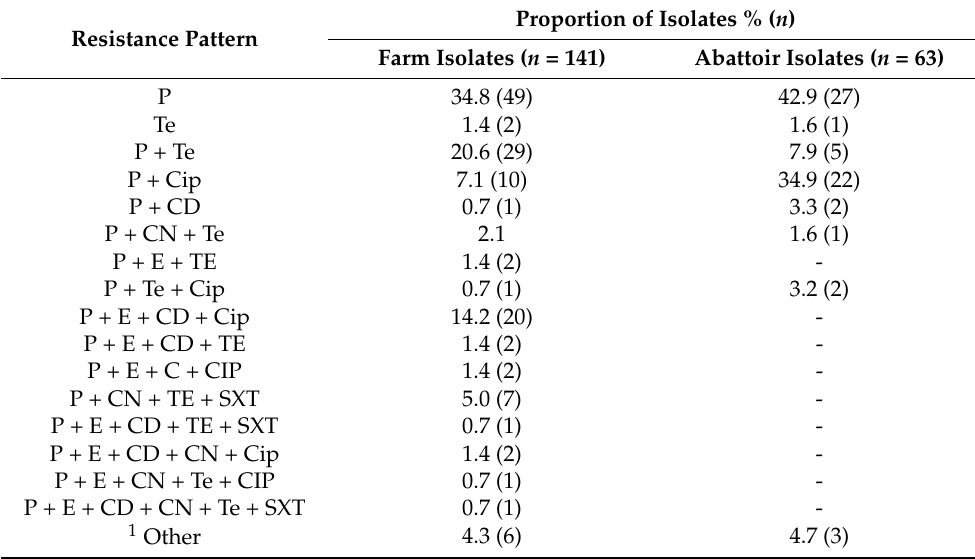
Table 3. Antibiotic resistance patterns of S. aureus isolates from pigs and workers from pig farms and abattoirs in Lusaka